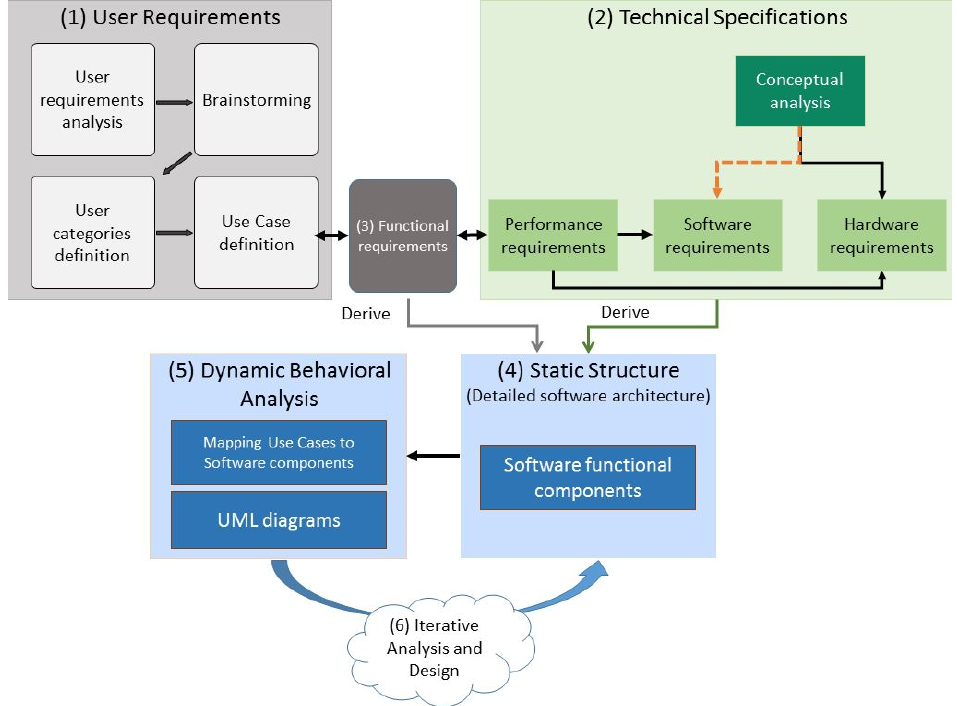
Figure 7. Architectural elements design process.